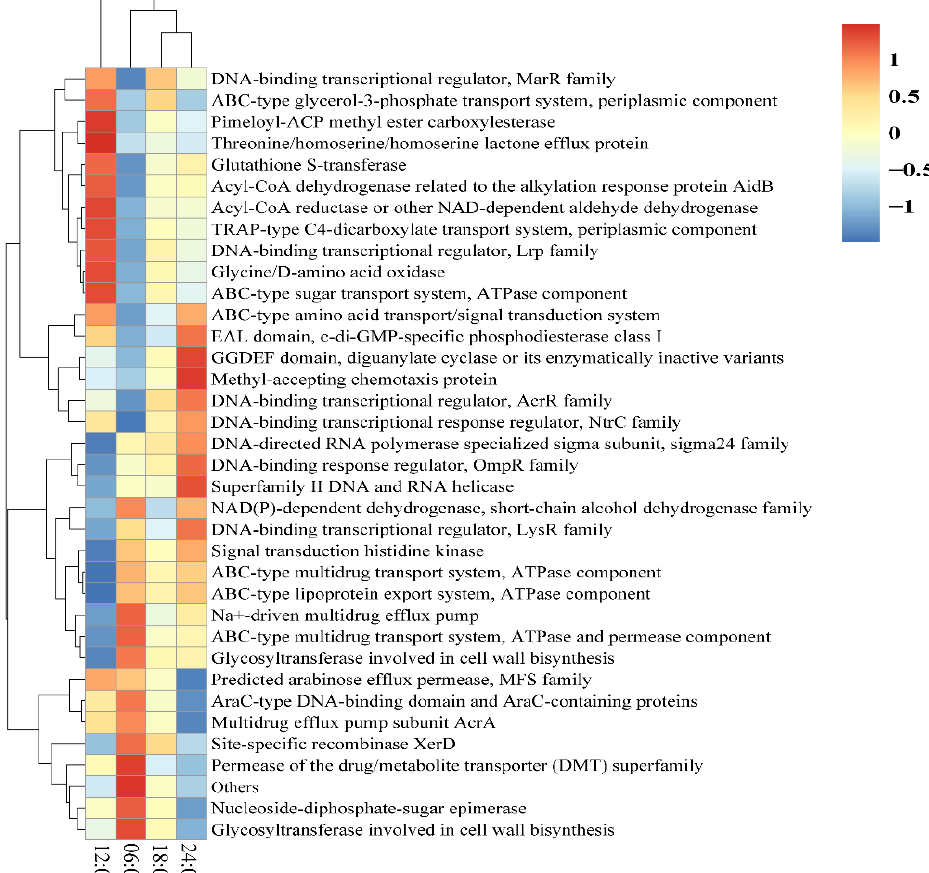
Figure 7. The relative abundance of gene function.